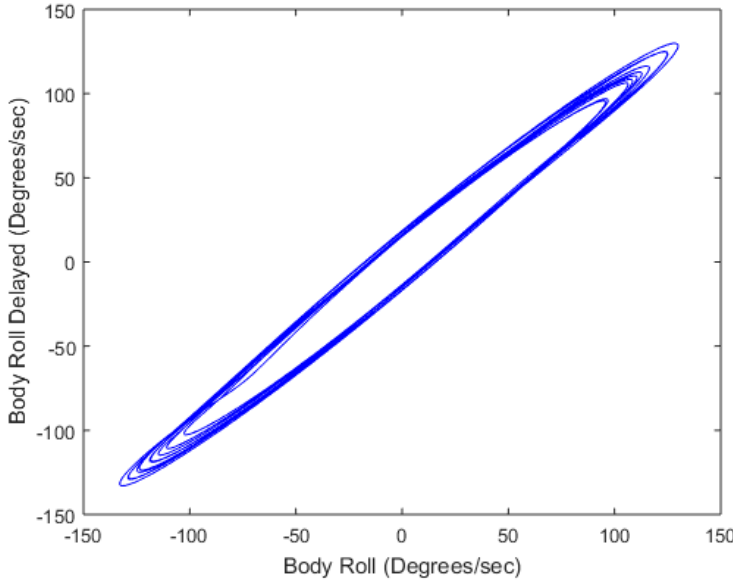
Figure 7. State-Space Based Visualisation technique demonstrating the consistency of the strokes using the body roll.